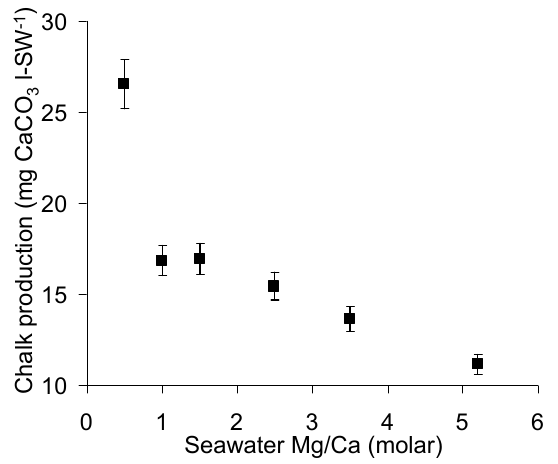
Fig. 14. Chalk production by Pleurochrysis carterae after seven days of growth in the six experimental seawater treatments. Chalk production increases as seawater Mg/Ca declines into the calcite stability field. Low seawater Mg/Ca favors precipitation of the coc- colithophores’ calcite skeletal mineral and is believed to have char- acterized seawater in Cretaceous time (Fig. 1) – when chalk pro- duction by coccolithophores was at its apex. Vertical bars represent measurement error. From Stanley et al. (2005).